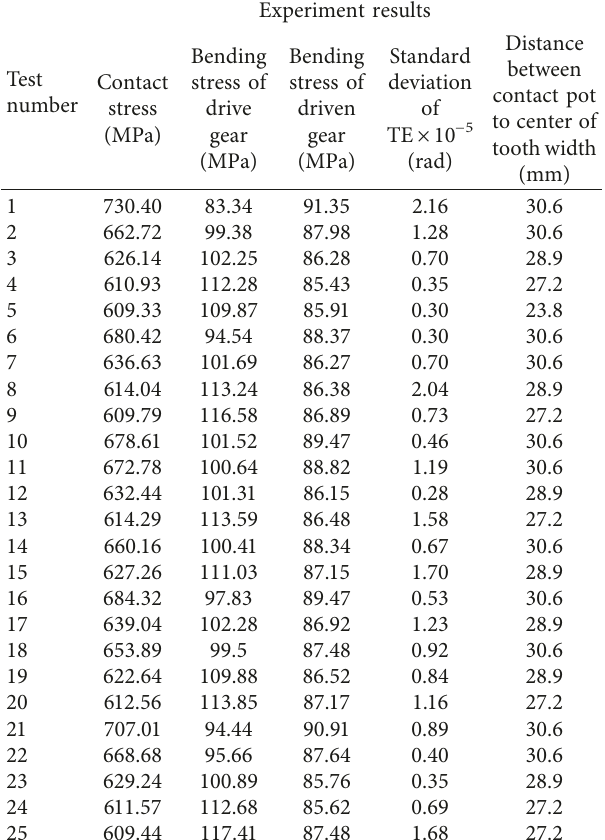
Table 3: Results of